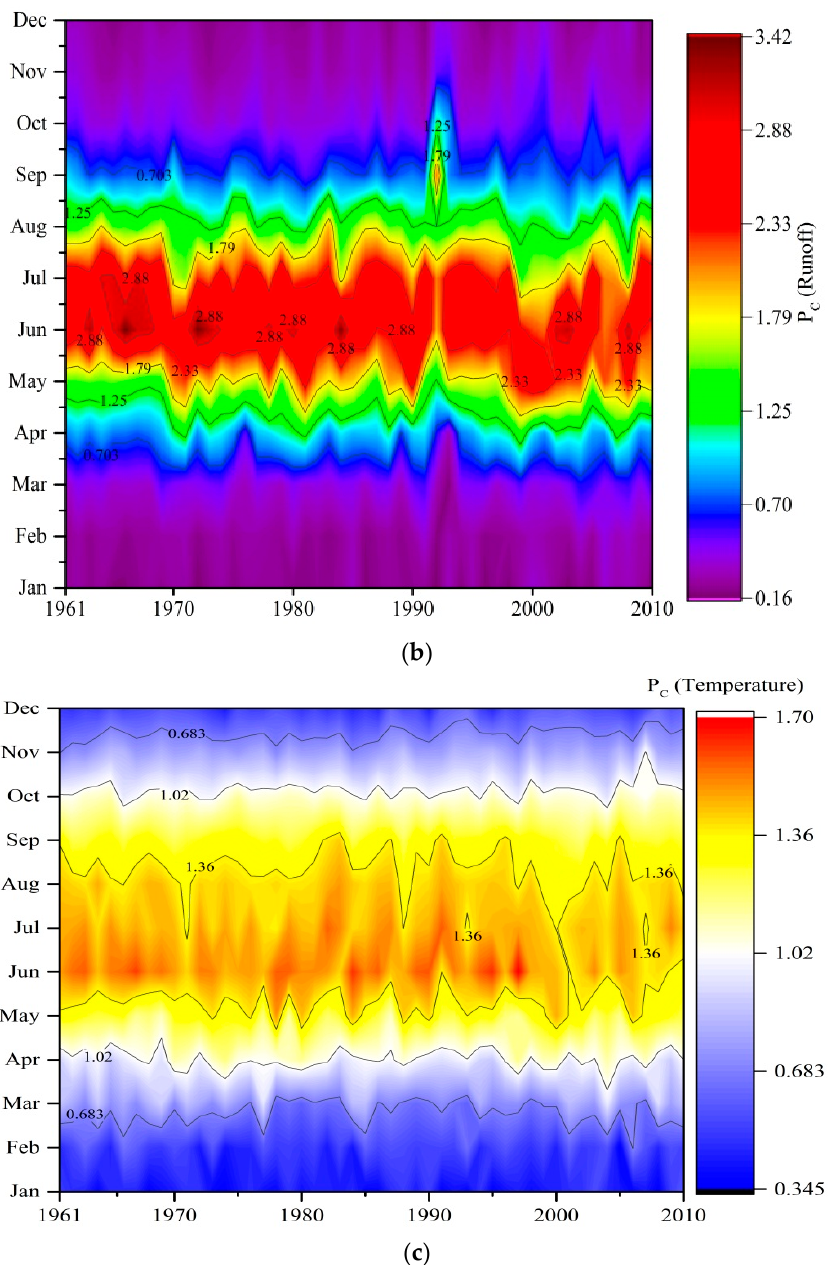
Figure 15. Contours of Parde co-efficient of precipitation, runoff and temperature of Zone II. ( a ) precipitation ( b ) runoff ( c ) temperature.